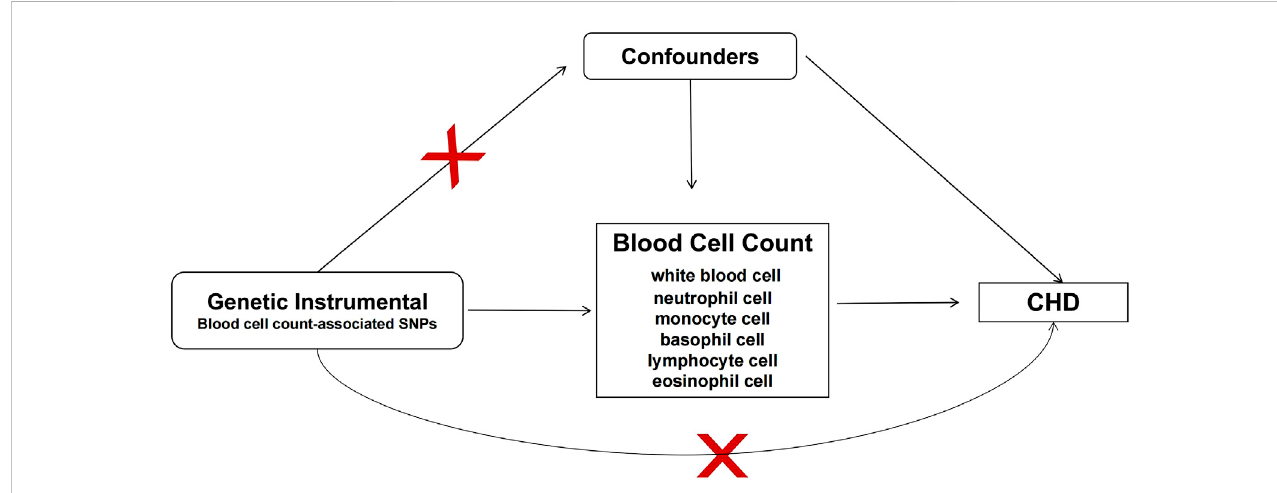
FIGURE 1 Study design of MR analysis. Conceptual schematic of the two-sample Mendelian randomization for the association between blood cell count and the risks of coronary heart disease. SNPs indicate single nucleotide polymorphisms; CHD, coronary heart